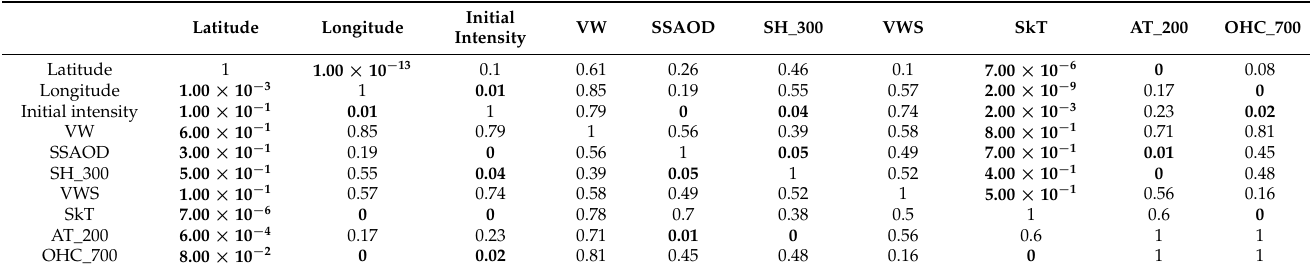
mainland landfall. Significant relationships at 0.05 level are shown in bold .